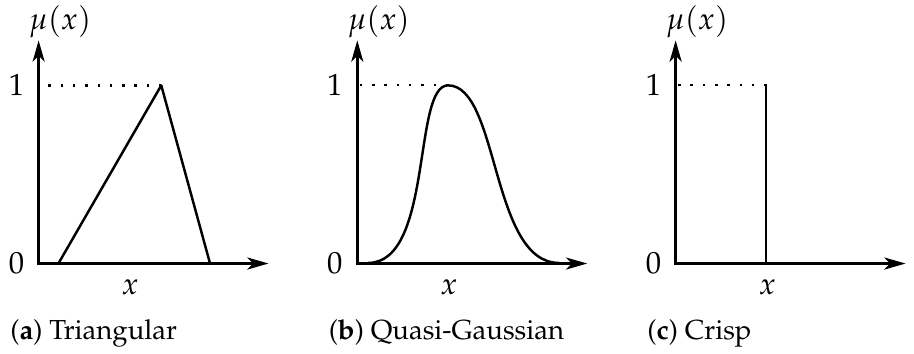
Figure 1. Fuzzy Number representations Figure 1. Fuzzy number